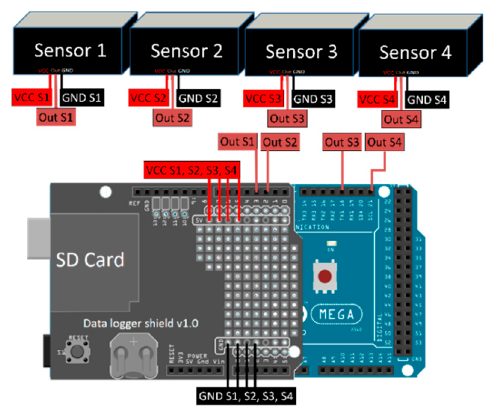
Figure 7. Connection of sensors, the Data Logger Shield v1.0 and the Arduino MEGA.